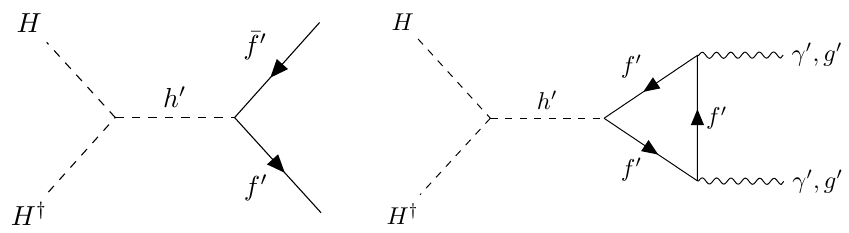
Figure 12 . Freeze-in production of mirror fermions (left) and mirror gauge bosons (right) through the Higgs